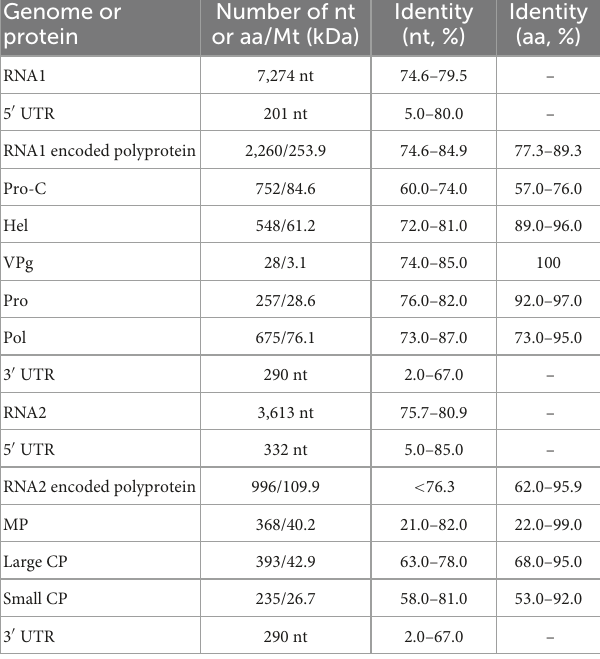
TABLE 5 The information on SLSRV-BJ and comparison of SLRSV-BJ sequence with the corresponding regions of other characterized SLRSV